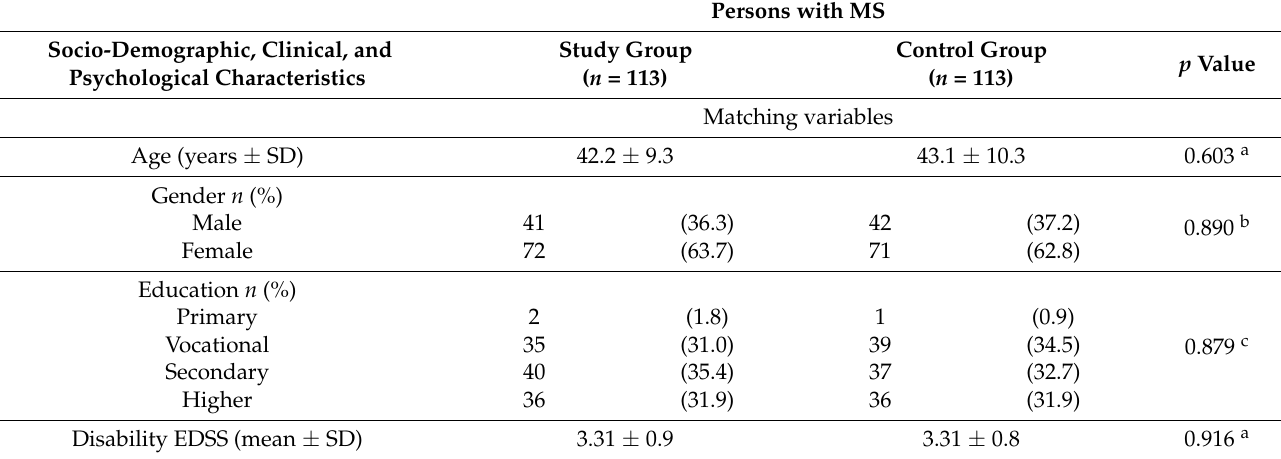
Table 1. Socio-demographic and clinical characteristic of persons with MS studied in 2020 and control group studied in 2017.